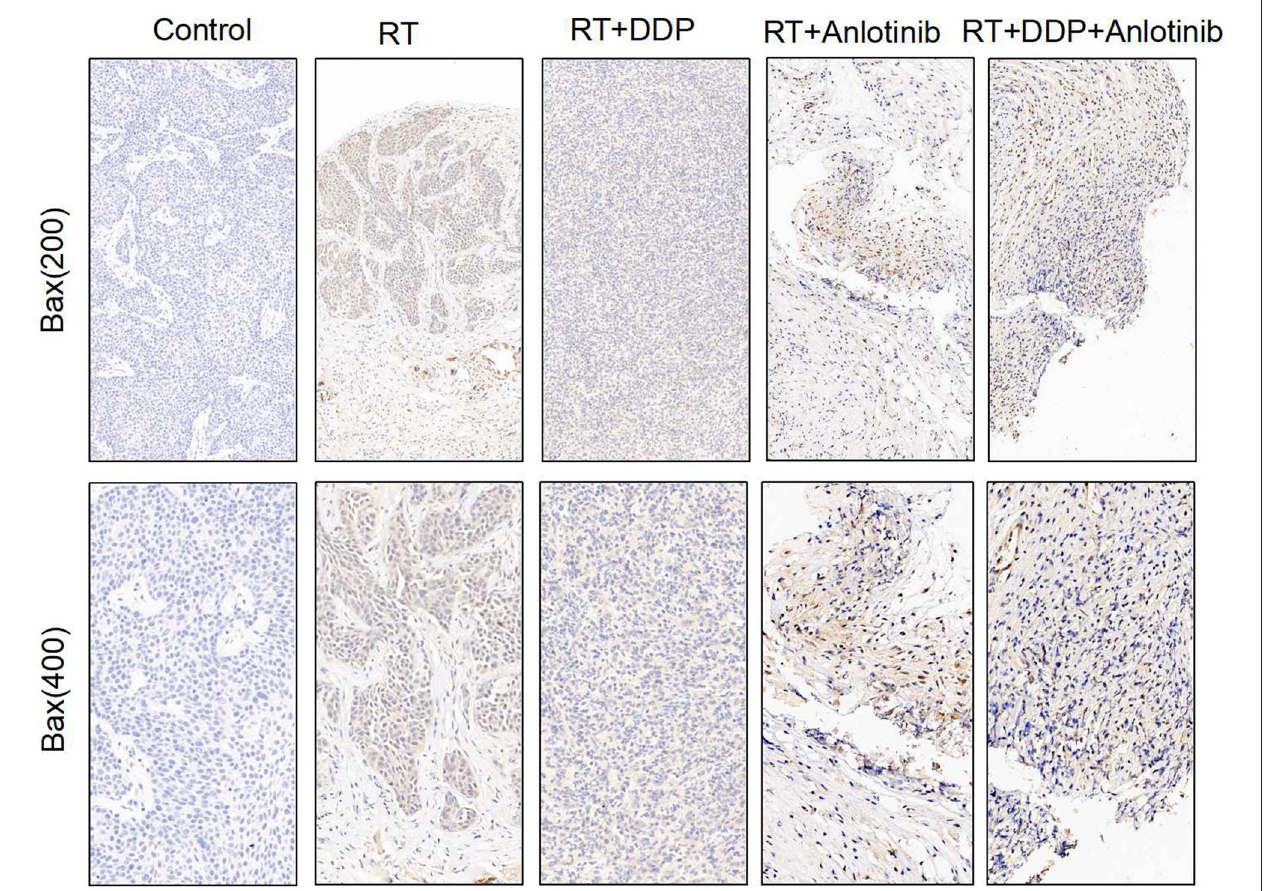
FIGURE 8 | Representative images for Bax immunohistochemistry show that brownish yellow nuclei and cytoplasm staining, respectively, indicate the positive cells. Varying degrees of positive rates were shown for the four treatment groups in which anlotinib combined with chemoradiation-treated group was the highest compared with the control group. The figure provided is a representative image, and other images are provided in the Supplementary Files. RT, radiation therapy; DDP,